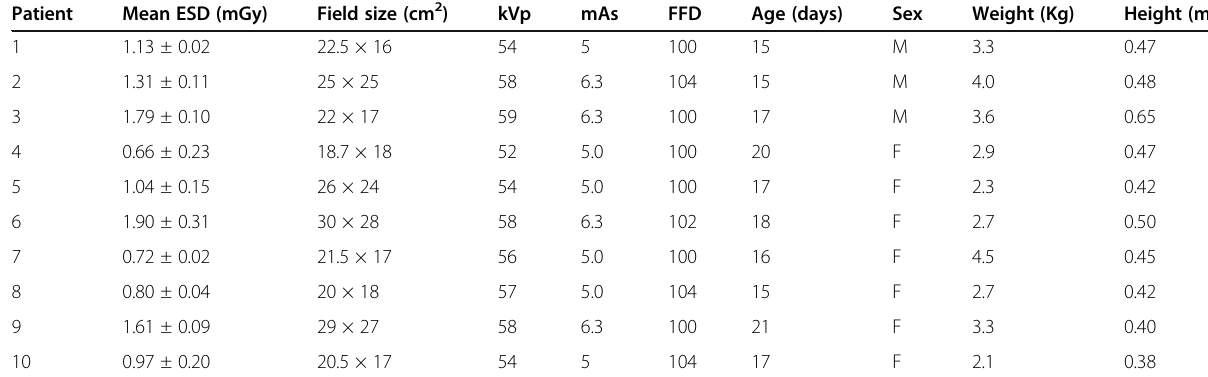
Table 4 Entrance surface dose (ESD) and other parameters for newborn between 15 and 21 days Patient